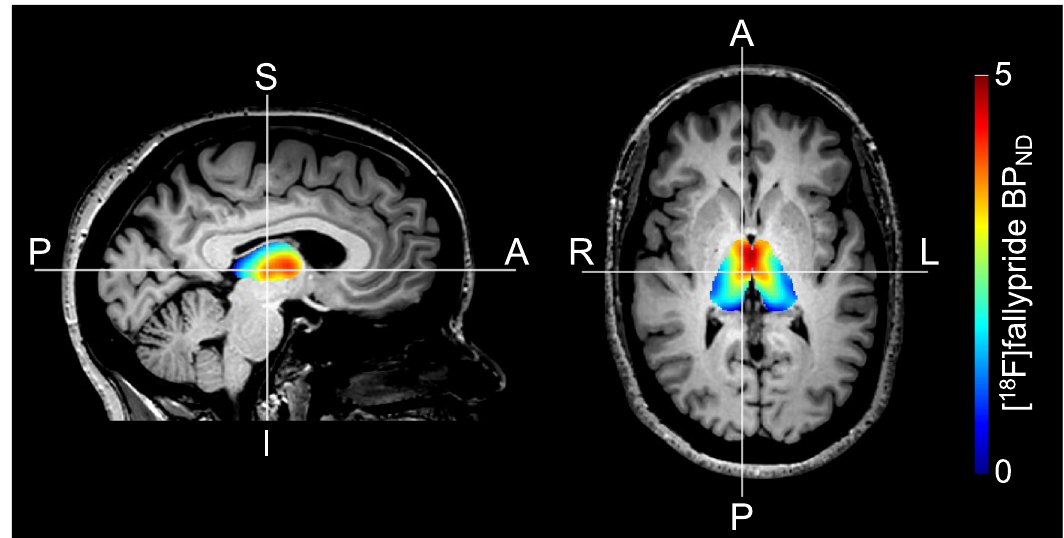
Fig. 3 Thalamic [ 18 F]fallypride BP ND . Representative example of [ 18 F]fallypride BP ND values in the thalamus overlaid on a T1-weighted image. −0.50.00.51.01.5